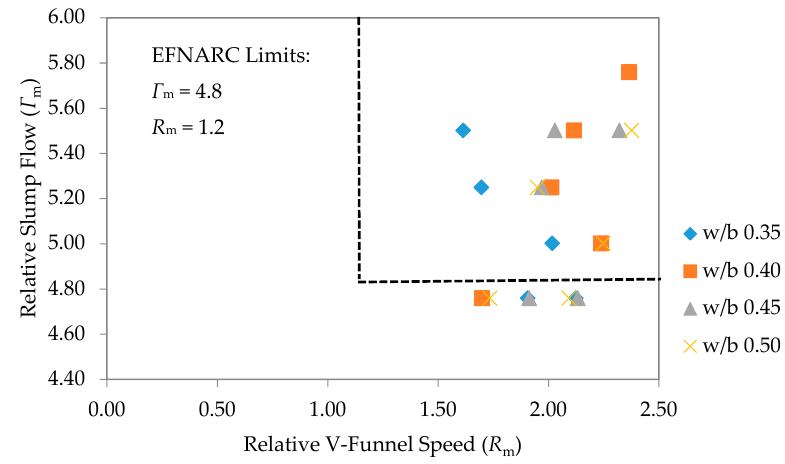
Figure 9. Relative slump flows and relative V-funnel speed.